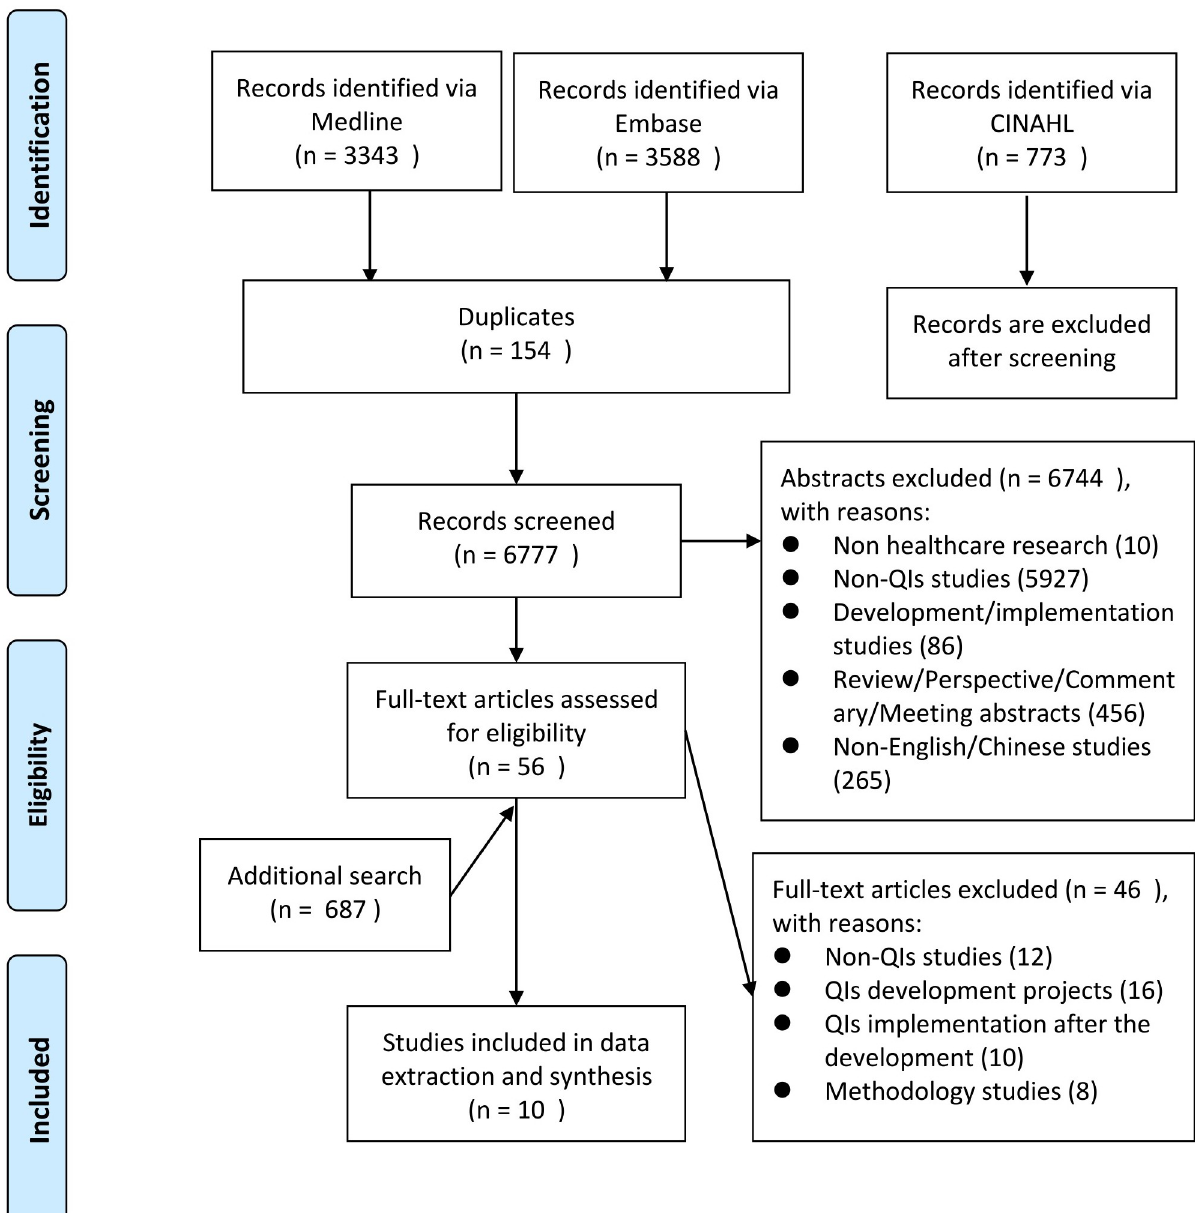
Fig 1. Flow diagram for study